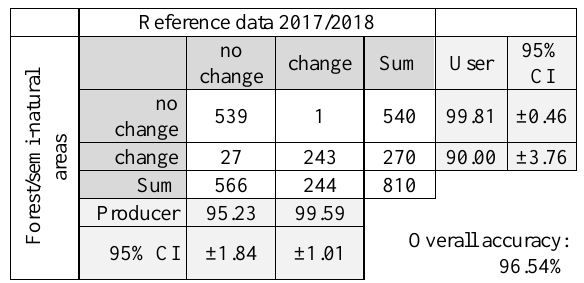
Table 6 . Confusion matrix for change layer Forest Table 7 shows the confusion matrix for the change layer for LBM-DE category “water surfaces”. Only 12 change polygons with an average size of 0.95 ha are identified. The overall